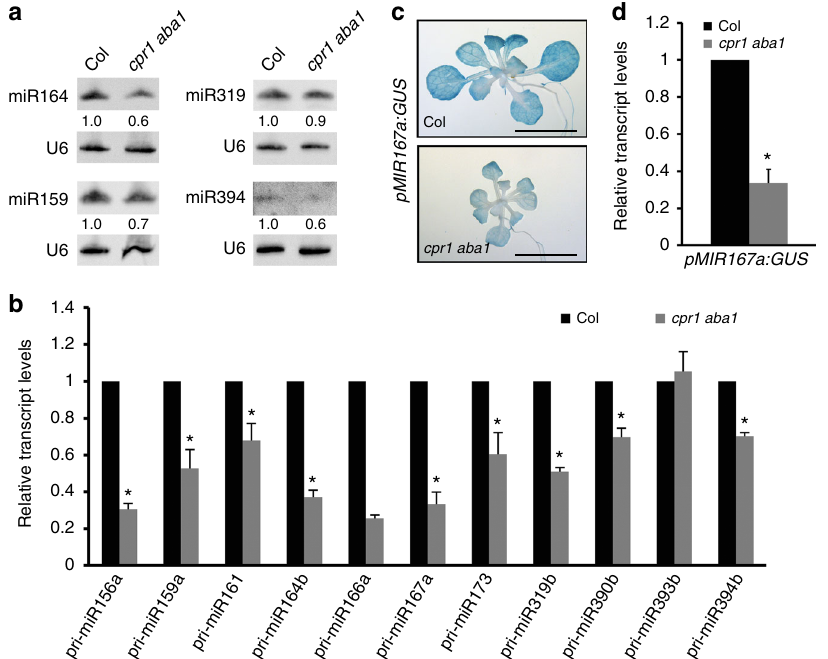
Fig. 3 MIR promoter activities are reduced in cpr1 aba1 . a Northern blots for four miRNAs in 15-day-old seedlings of wild type (Col) and cpr1 aba1 . U6 served as the loading control. The numbers indicate relative abundance. b The levels of eleven pri-miRNAs in wild type (Col) and cpr1 aba1 as determined by quantitative RT-PCR. Error bars represent standard deviation calculated from three biological replicates ( * Student ’ s t test: P < 0.05). c GUS staining of pMIR167a:GUS and pMIR167a:GUS cpr1 aba1 seedlings. Note that the pMIR167a:GUS transgene was at a single locus and was homozygous in the two lines. The staining was visibly lower in pMIR167a:GUS cpr1 aba1 . Bar = 5 mm. d GUS transcript levels as determined by quantitative RT-PCR analysis of the genotypes in c . Error bars represent standard deviations calculated from three biological replicates ( * Student ’ s t test: P < 0.05). Source data are provided as a Source Data fi